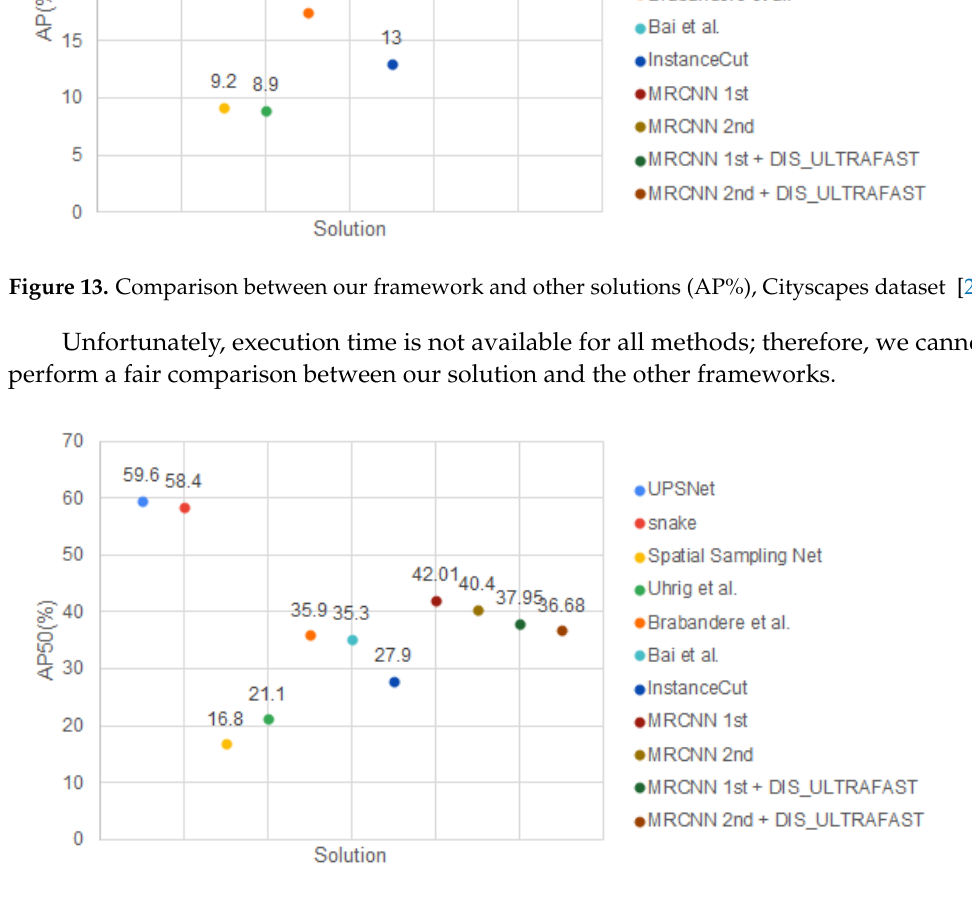
Figure 14. Comparison between our framework and other solutions (AP50%), Cityscapes dataset